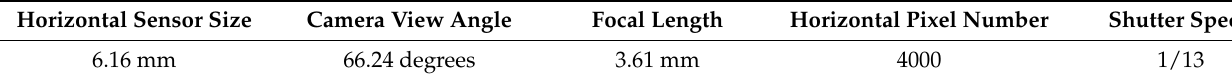
Figure 4. Data acquisition equipment: unmanned aerial vehicle 3DR Site scan. Table 1. Interior orientation of the sensor installed on the UAV.